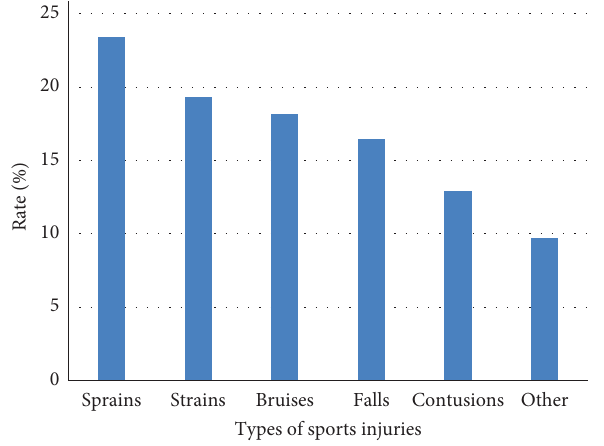
Figure 5: Types of sports injuries in